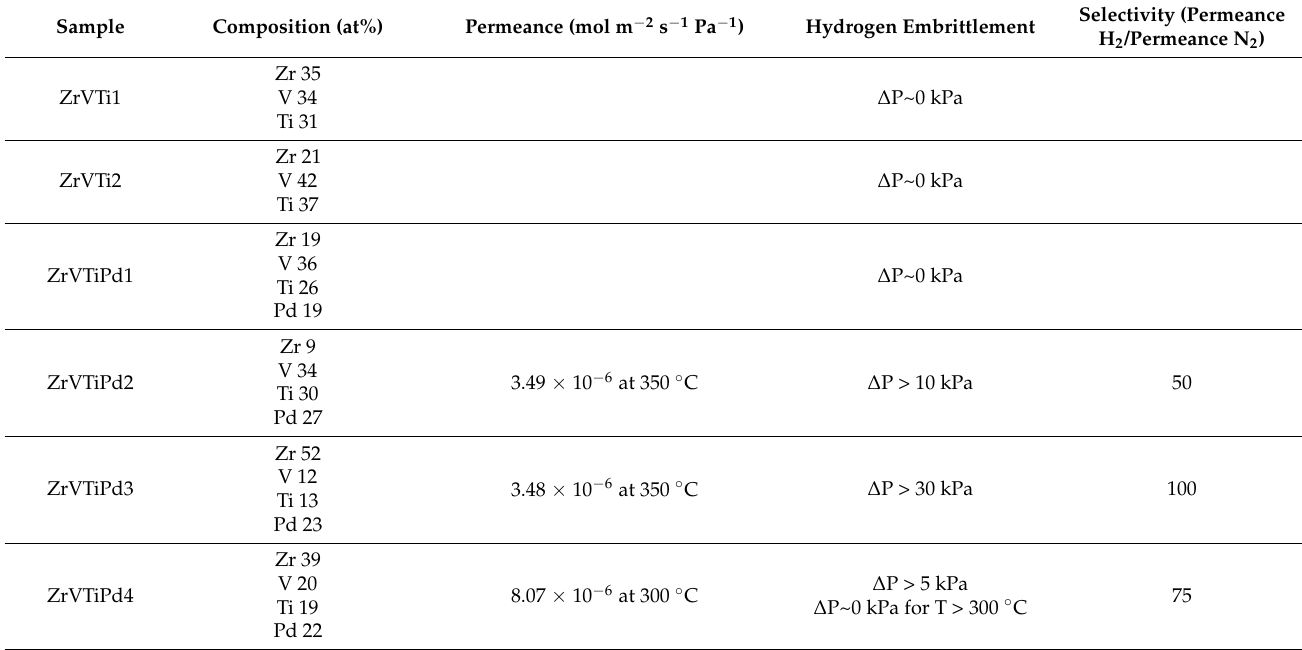
Table 2. Hydrogen permeance, selectivity, and embrittlement resistance values for some membranes (the composition is also reported to ease the